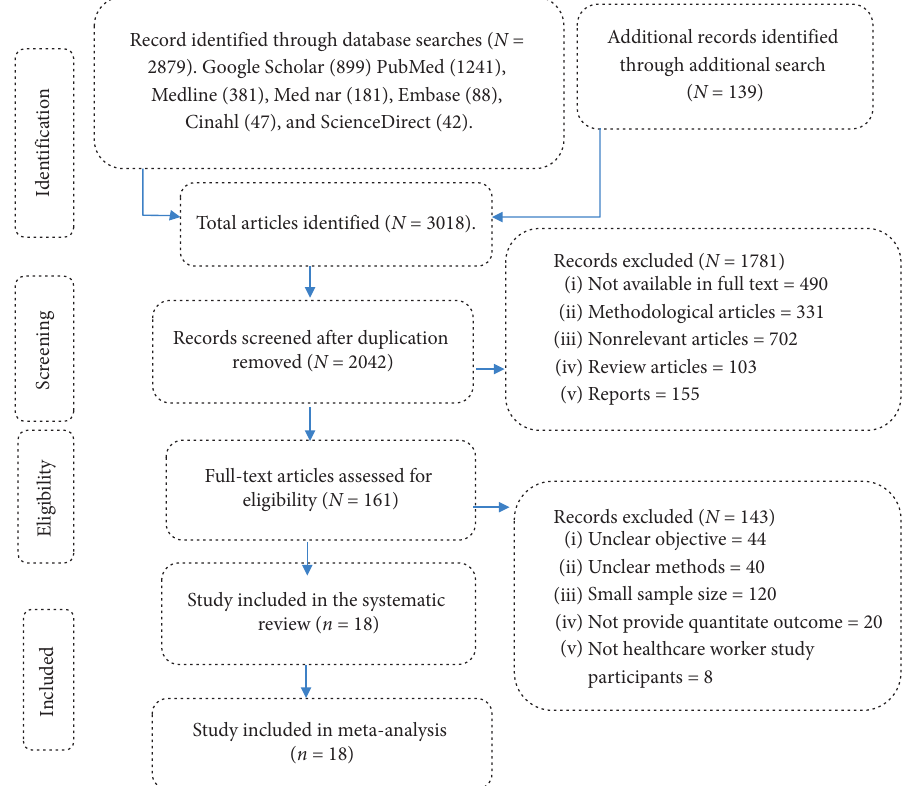
Figure 1: PRISMA flow diagram shows the selection process of included articles for a systematic review and